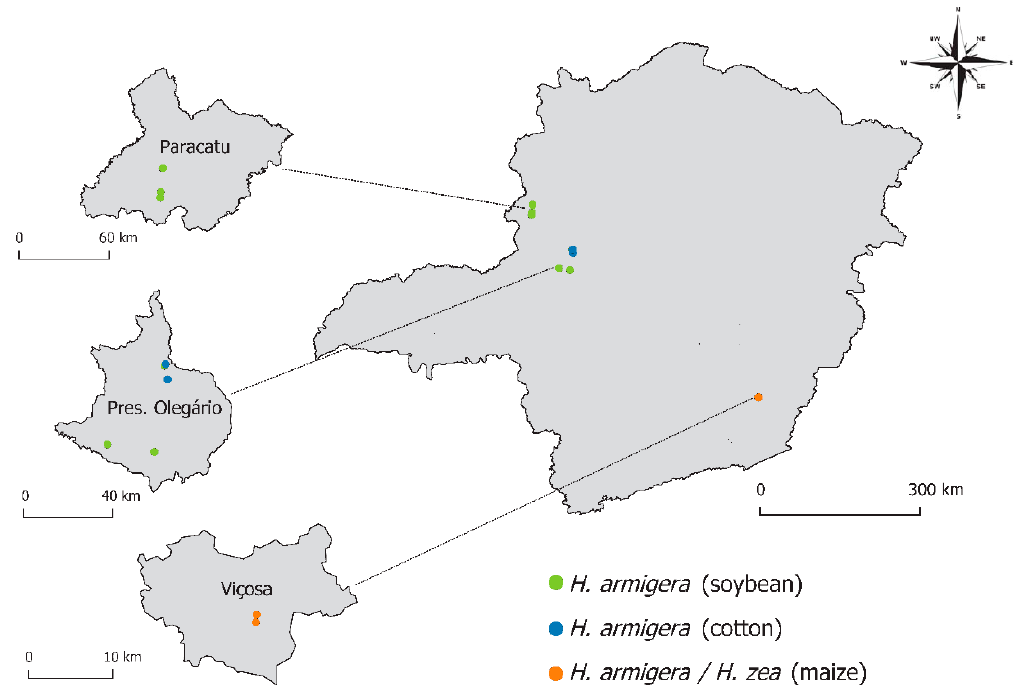
Figure 2. Sampling sites in the State of Minas Gerais where Helicoverpa armigera and Helicoverpa zea were collected in the study. The ten samplings sites were focused in three municipalities (Highlighted maps: Paracatu, Presidente Olegário and Viçosa). Individuals of H. armigera were found in six soybean (green circles) and two cotton (blue circles) sampling sites, including Bt and Non-Bt crops. Mixed infestations between H. armigera and H. zea were found in two sampling sites with non-Bt maize crop (orange circles).